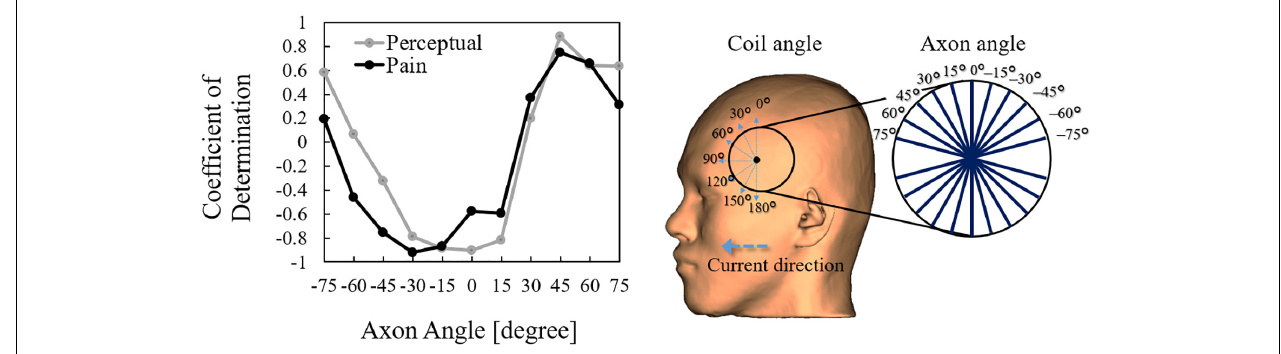
FIGURE 6 | Correlation between the activation threshold (nerve) and induced electric field (computational dosimetry of experimental condition) at different coil orientations. The correlation is obtained using different axon angles above the Broca’s